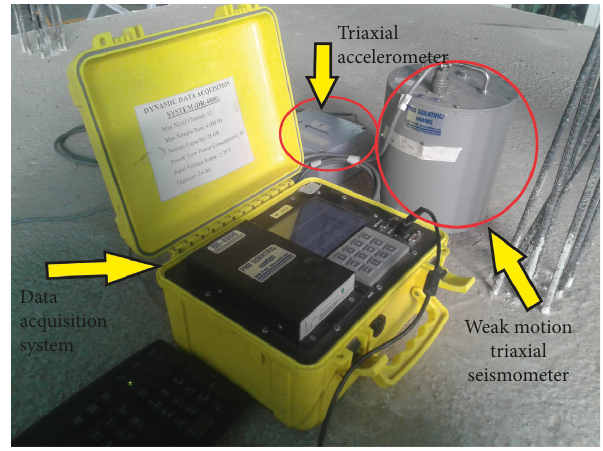
Figure 12: Test setup for the free vibration